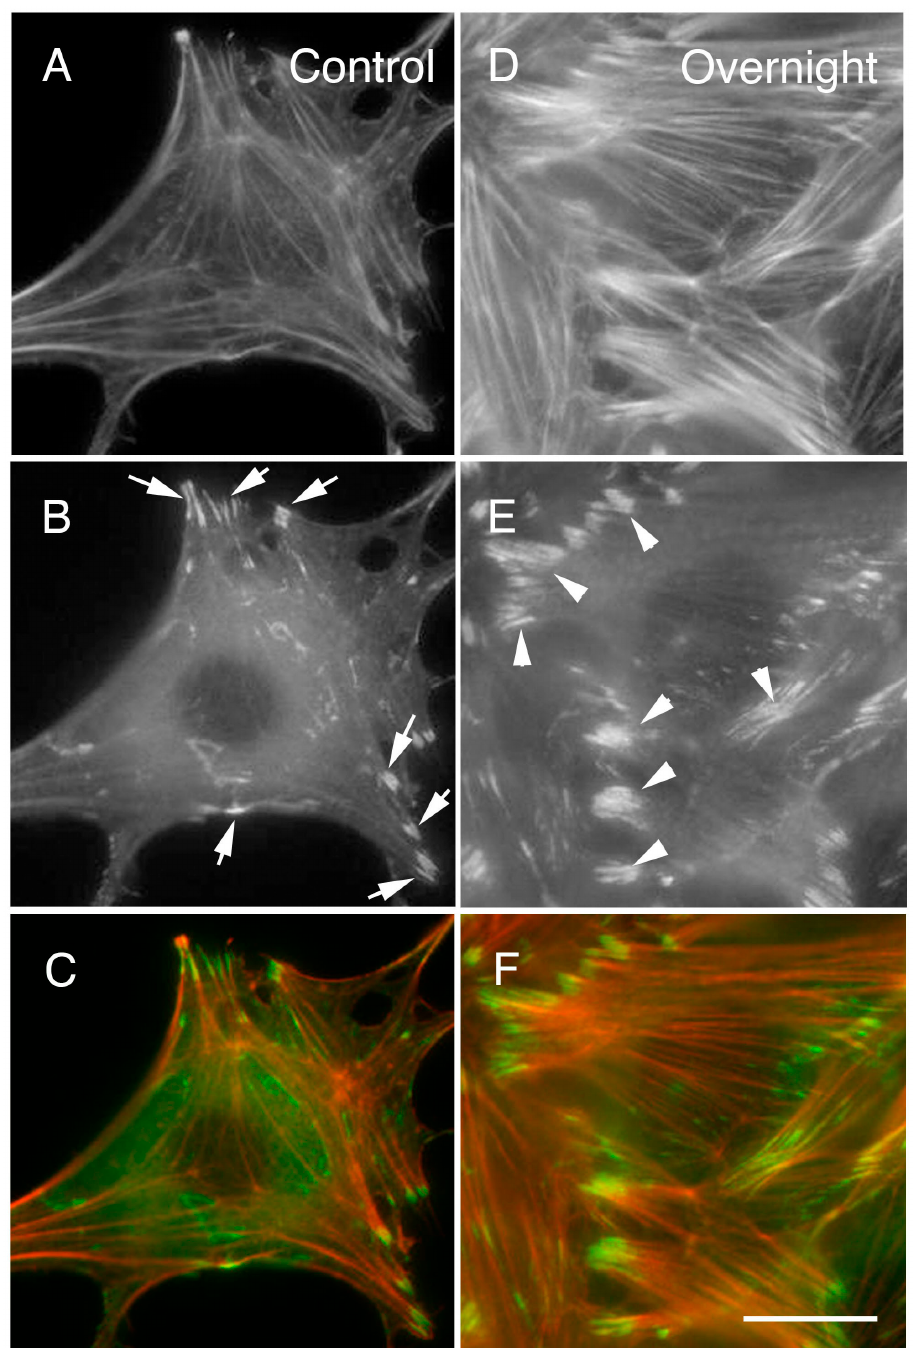
Figure 2. More and larger focal adhesions and stress fibers were observed after periodic electrical stimulation. An increase in the number and size of focal adhesions and stress fibers was observed after periodic electrical stimulation. After 20 h of such stimulation, both the stress fibers and focal adhesions had thickened and enlarged ( D – F ) compared with those in the control (no electrical stimulation) ( A – C ). ( A – C ): Control (no electrical stimulation); ( A ): Rhodamine phalloidin; ( B ): GFP-paxillin; ( C ): Merge ( D – F ): 20 h of electrical stimulation; ( D ): Rhodamine phalloidin; ( E ): GFP-paxillin; ( F ): Merge. The arrows in ( B ) indicate typical focal adhesion before electrical stimulation (control); the arrowheads in E indicate enlarged focal adhesions after electrical stimulation for 20 h. Bars: 10 µ m (all figures are of the same magnification). See also Katoh (2022) [2].